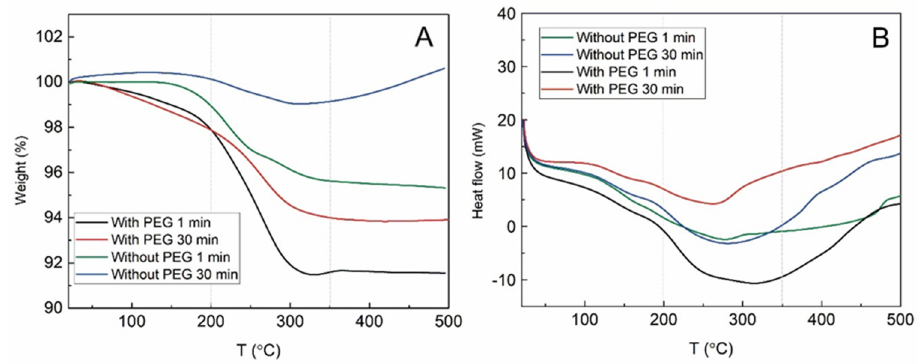
Figure 6. Preparation time at 250 °C-dependent FTIR spectra of KBr dispersed particles that were produced with ( A ) and without ( B ) PEG. The ATR-FTIR spectra of sodium acetate, PEG and ethylene glycol (EG) ( C ). The spectral positions in ( A ) and ( B ) were worked out from the second derivative spectrum calculated using the Savitzky–Golay algorithm.